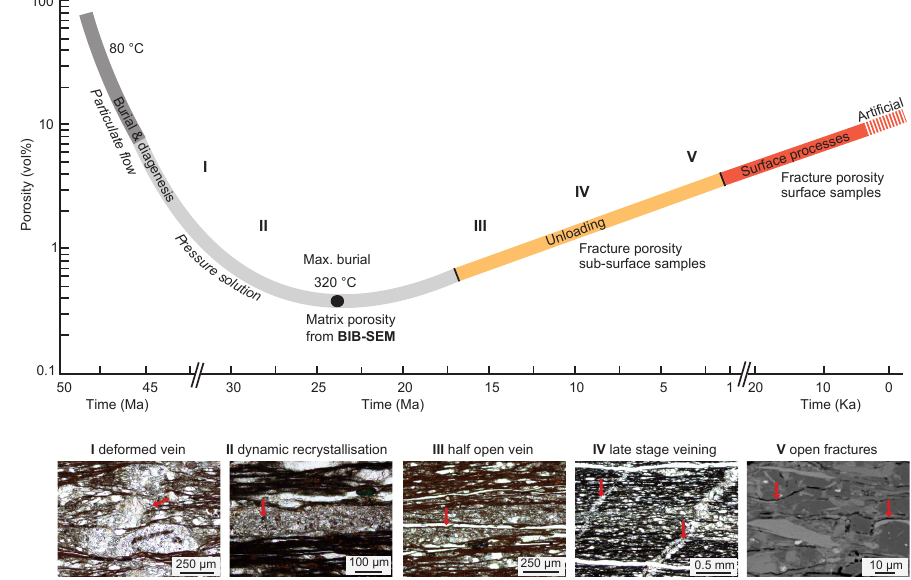
Figure 14. Conceptual porosity evolution over time linked to different vein generations and fractures. Porosity at max. burial is from BIB- SEM, porosity on retrograde path is based on He-pycnometry and MIP data. Boundaries between different domains are estimates. Tectonic processes on prograde path from Dielforder et al.